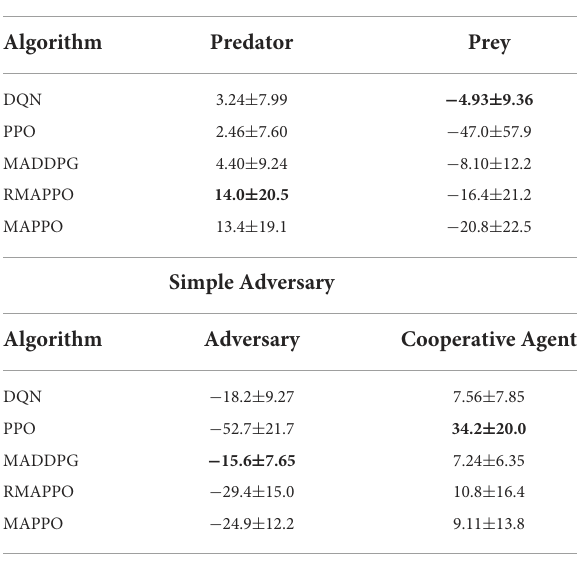
TABLE 3 Final scores (mean and standard deviation) of algorithms obtained over the last 100 episodes across all 5 seeds in the Simple Tag and Simple Adversary